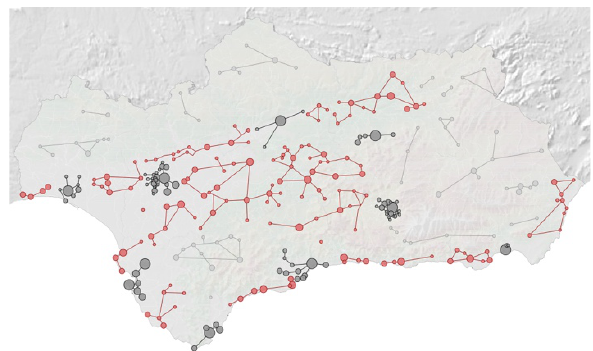
Figure 1. Andalusian Urban System according to POTA (2006). Marked in dark grey, the urban systems formed by Regional Centres, in red those by Medium-Sized Cities and in light grey those by Rural Areas (The authors,